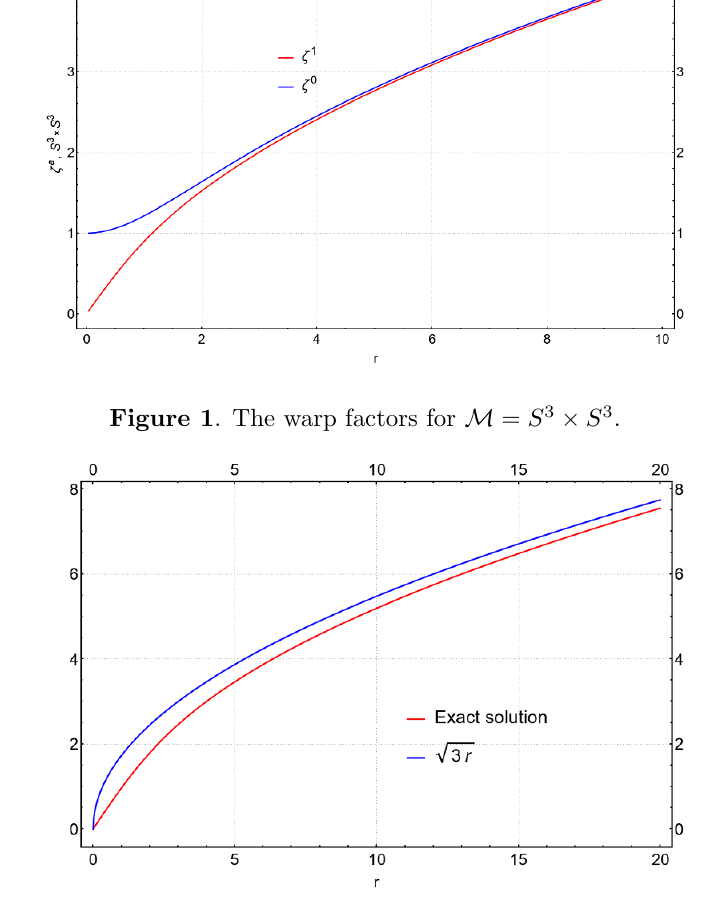
Figure 2 . The S 4 warp factor for M = R 2 (cid:2) S 4